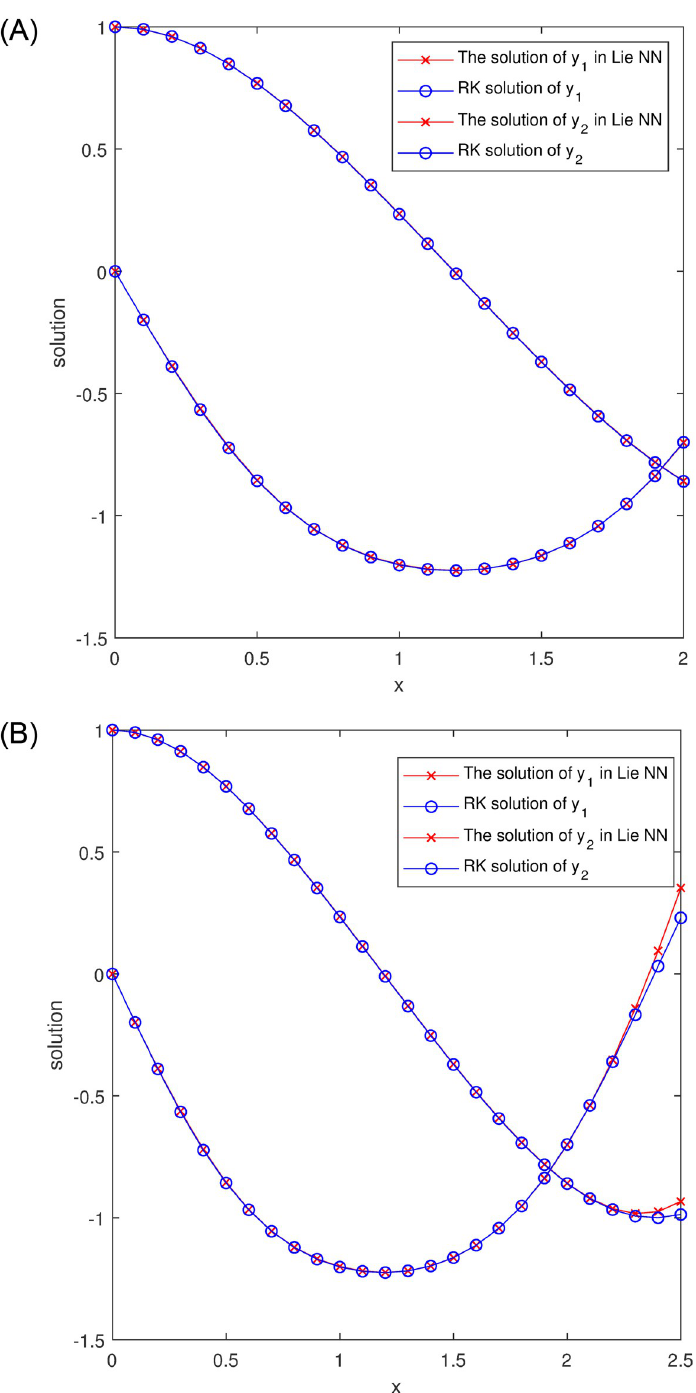
Fig 10. Comparison between our solutions ^ y